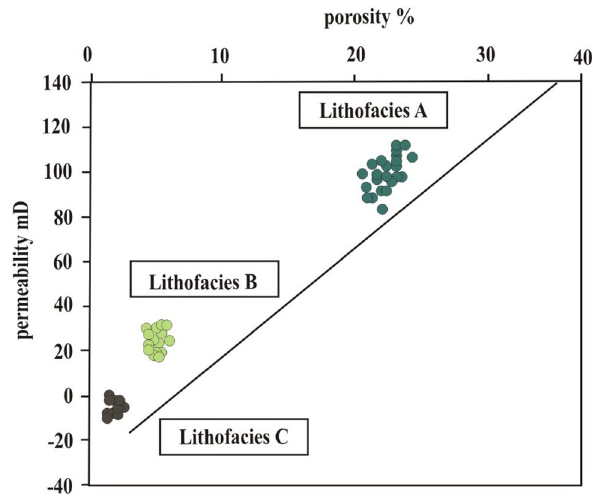
Fig. 12 Cross-plot porosity and permeability of representative sam- ples from the Haymana Formation